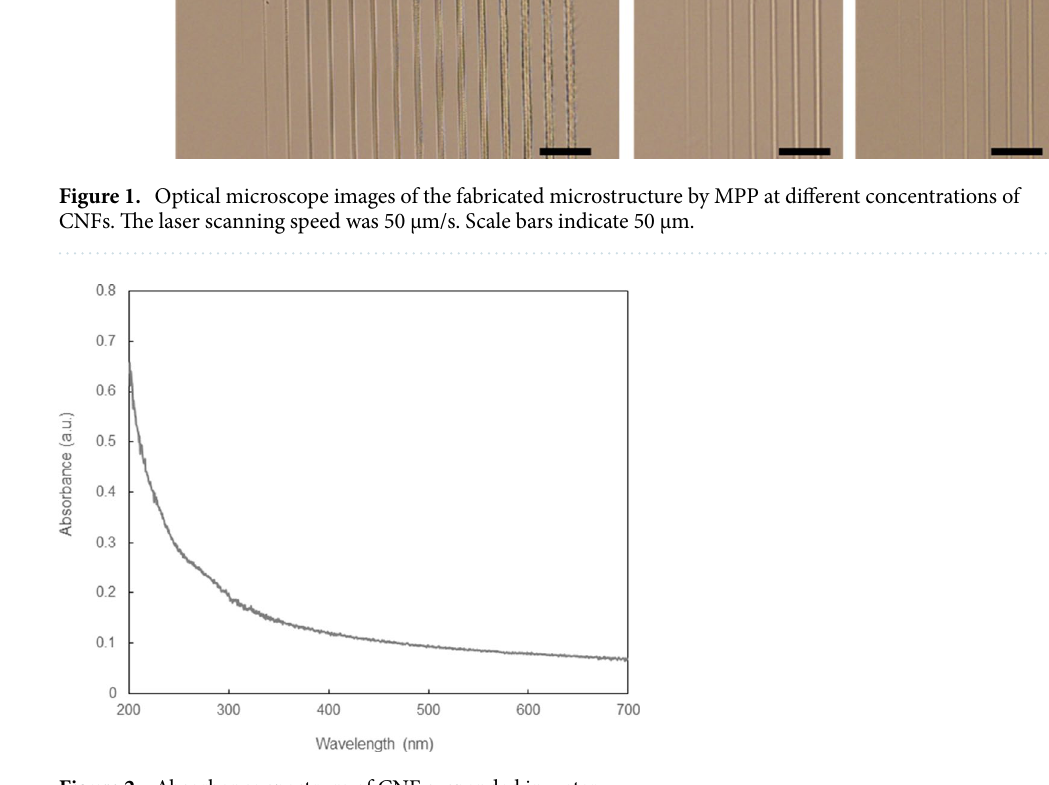
Figure 2. Absorbance spectrum of CNF suspended in